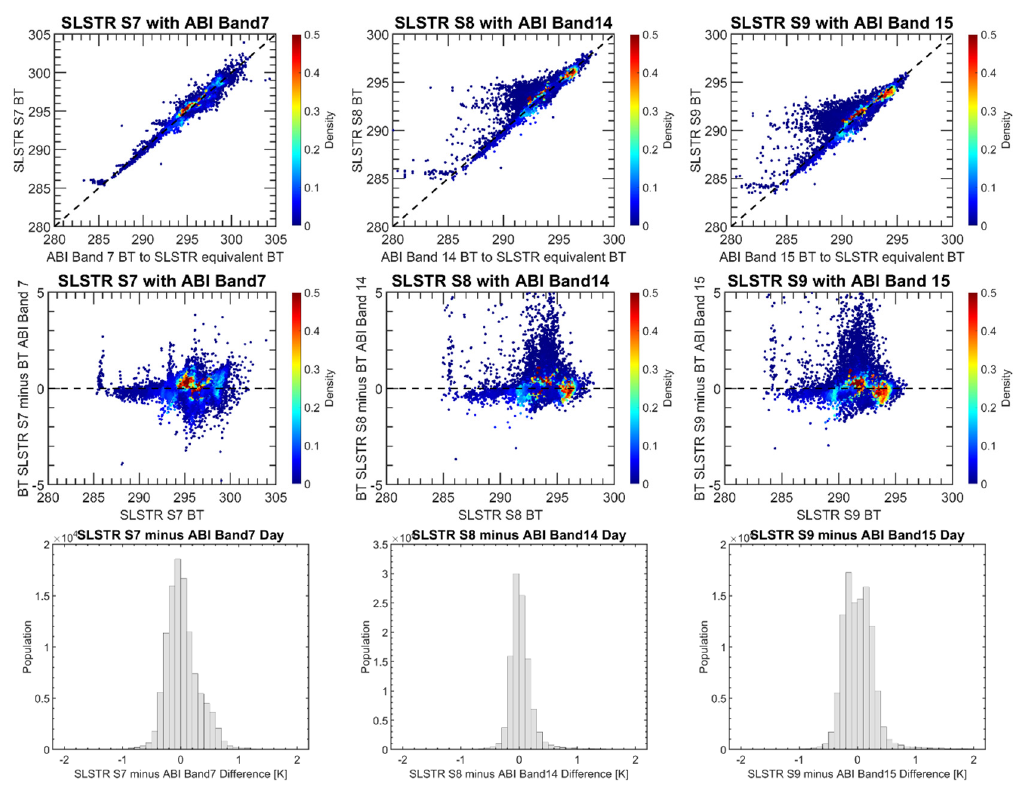
Figure 5. First row: scatter plots of the ABI equivalent BTs as a function of the SLSTR BTs of each channel pair. The colors show the density of the data according to the scale on the right. Second row: scatter plots of the SLSTR minus ABI BTs as a function of the SLSTR BT. Third row: histograms of the SLSTR minus ABI BTs. All of the ABI BTs indicate the transferred SLSTR-equivalent BTs. The BTs are divided into 0.5 K intervals. The density shows the number of matched points within 0.2 K times 0.2 K BT cells divided by the maximum number.